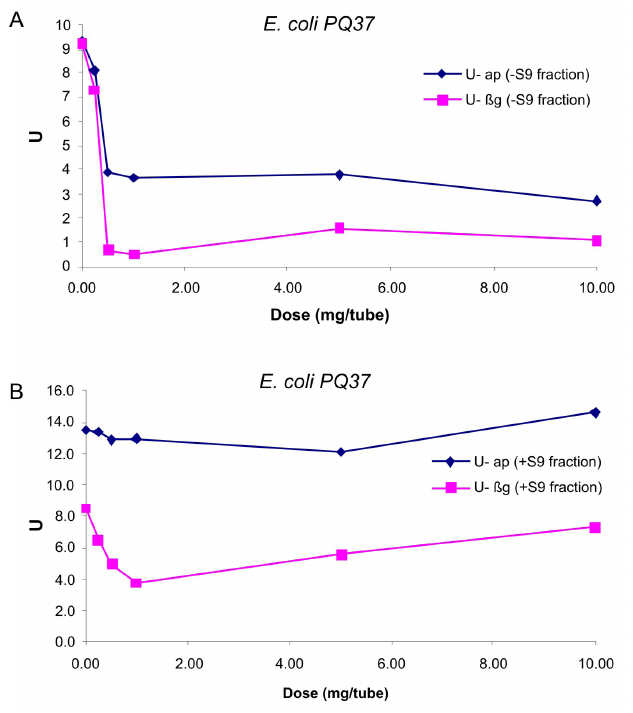
FIGURE 7 - Enzymatic Units (U) of enzymes b -galactosidase ( b g) and alkaline phosphatase (ap) as a function of dose (mg/ tube) of “barbatimão” extract (BE), in the absence (A) or presence (B) of S9 fraction on E. coli PQ37. The maximum coefficient of variation (CV) of experiments was 10%. Plots represent average of four independent